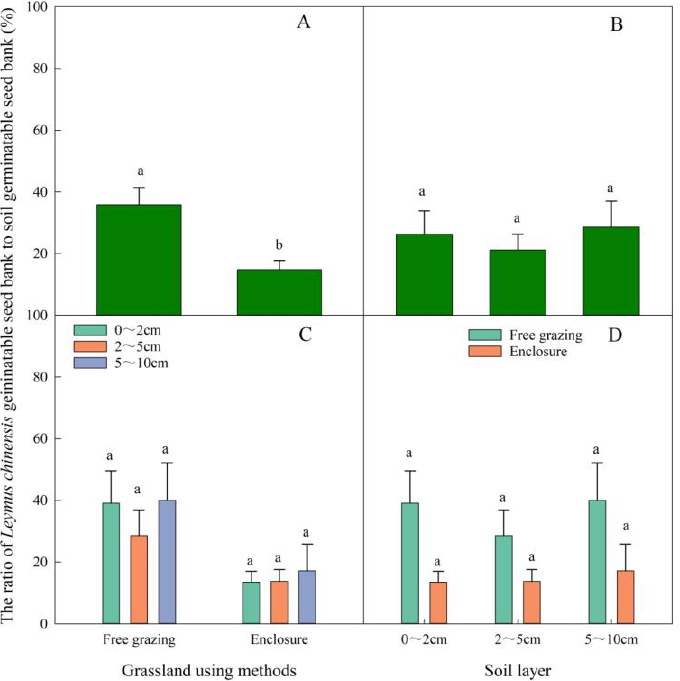
Figure 3. Effects of grassland use and soil layer on the ratio of germinable Leymus chinensis seed bank to soil germinable seed bank. Note: Lowercase letters represent significant differences between different using methods or different soil layers ( p < 0.05). Subfigure ( A ) shows the ratio of total germinated L. chinensis seeds at 0 – 10cm to the total number of soil germinated seeds at 0 – 10cm under different using methods. Subfigure ( B ) shows the ratio of total germinated L. chinensis seeds of free grazing and enclosure to the total number of soil germinated seeds at different soil layers. Subfigures ( C , D ) show the ratio of germinated L. chinensis seeds to the number of soil germinated seeds under different using methods and soil layers.